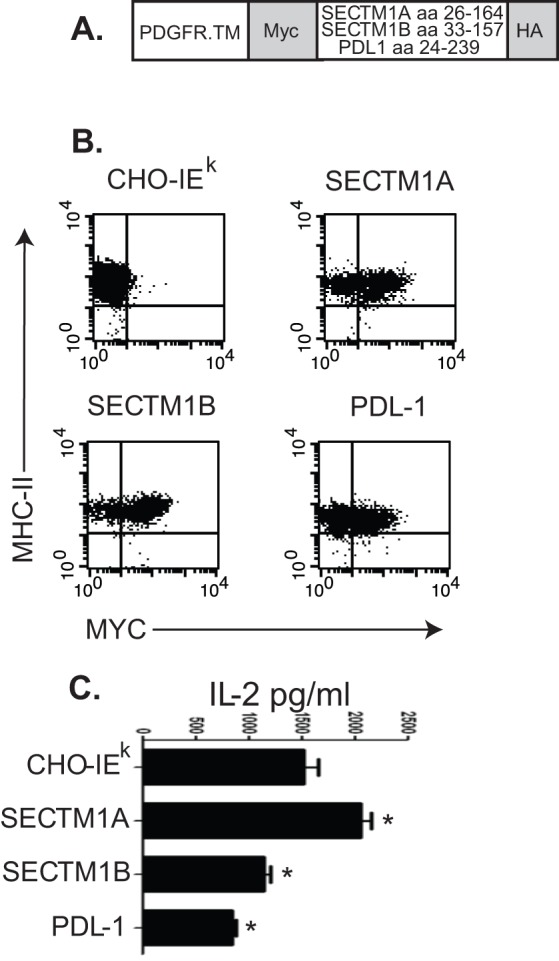
Cell surface targetted SECTM1A enhances IL-2 production by antigen specific T cells.A. Diagram of the structure of pDISPLAY based constructs for cell surface expression of SECTM1A/B and PDL1 on CHO cells expressing MHC class II ‘CHO-IEk’. The regions of SECTM1A/B and PDL1 between the leader sequence and plasma membrane transmembrane sequence were used. B. Flow cytometry for MHC class II and Myc (to detect cell surface SECTM1A/B or PDL1) on CHO-IEk cells. C. ELISA measurement of IL-2 in 48 hour co-culture of male peptide-pulsed CHO-IEk cells and A1.RAG T cells. Representative of two separate experiments. * = p<0.05 by Student's t test.